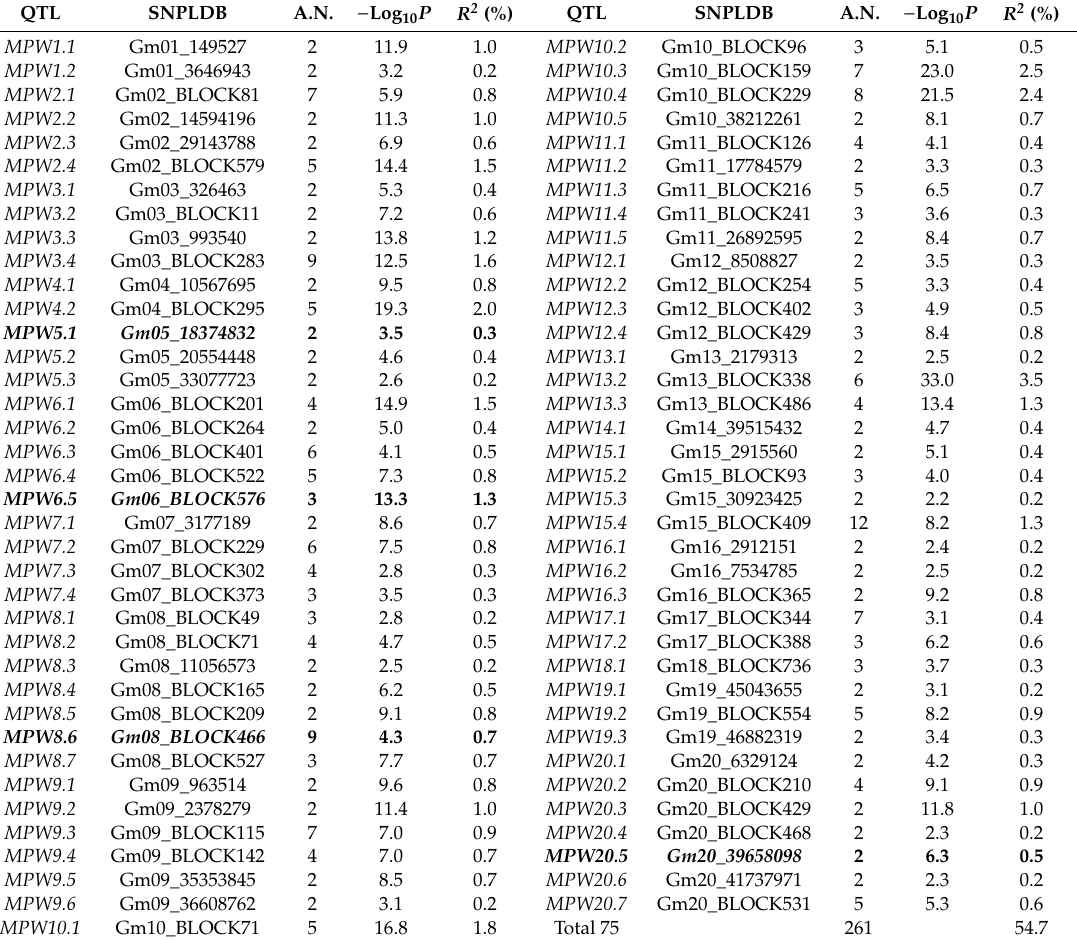
Table 2. The QTL conferring drought tolerance in terms of MPW in